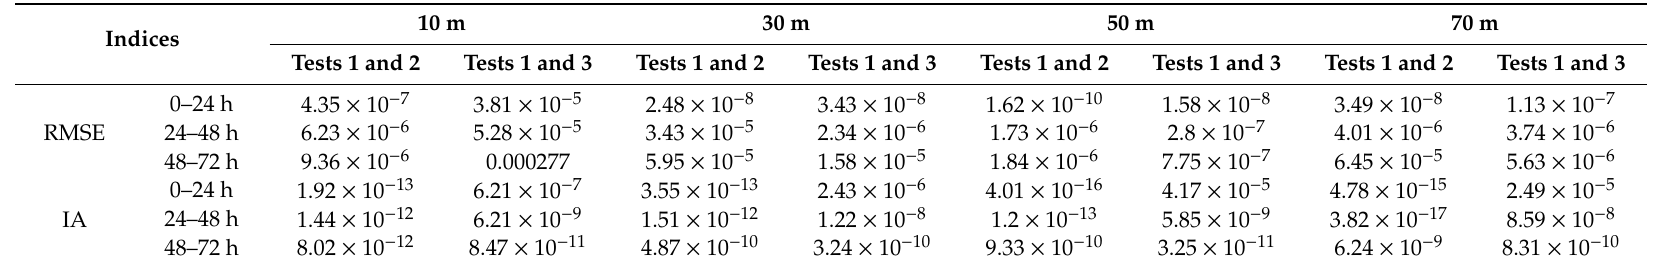
Table 14. p -value of each significance